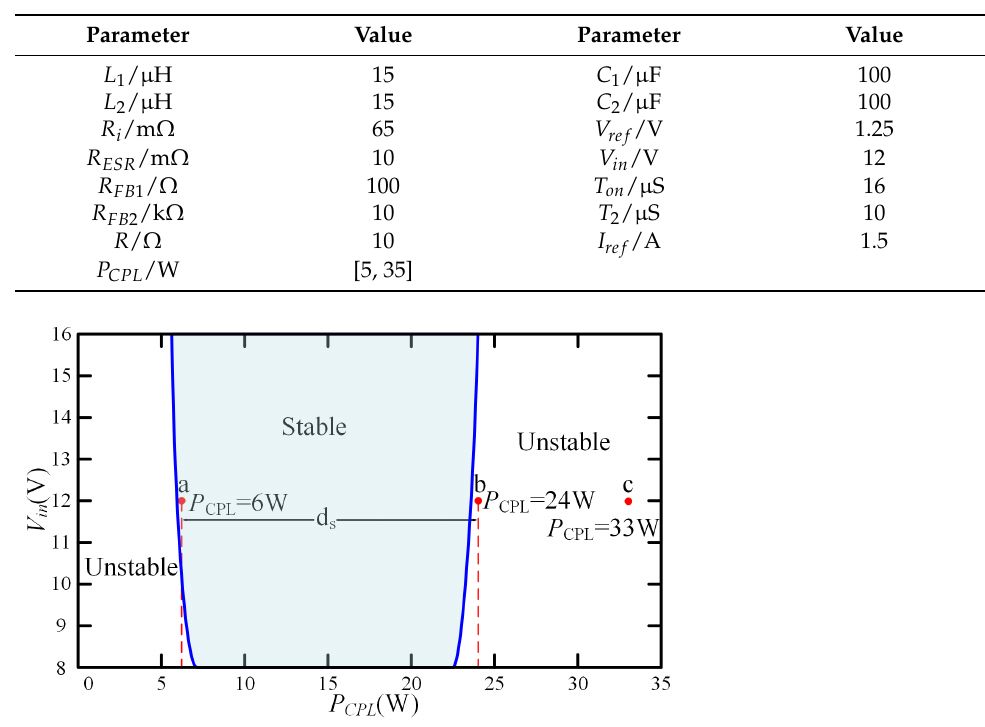
Table 1. Parameters of the system.